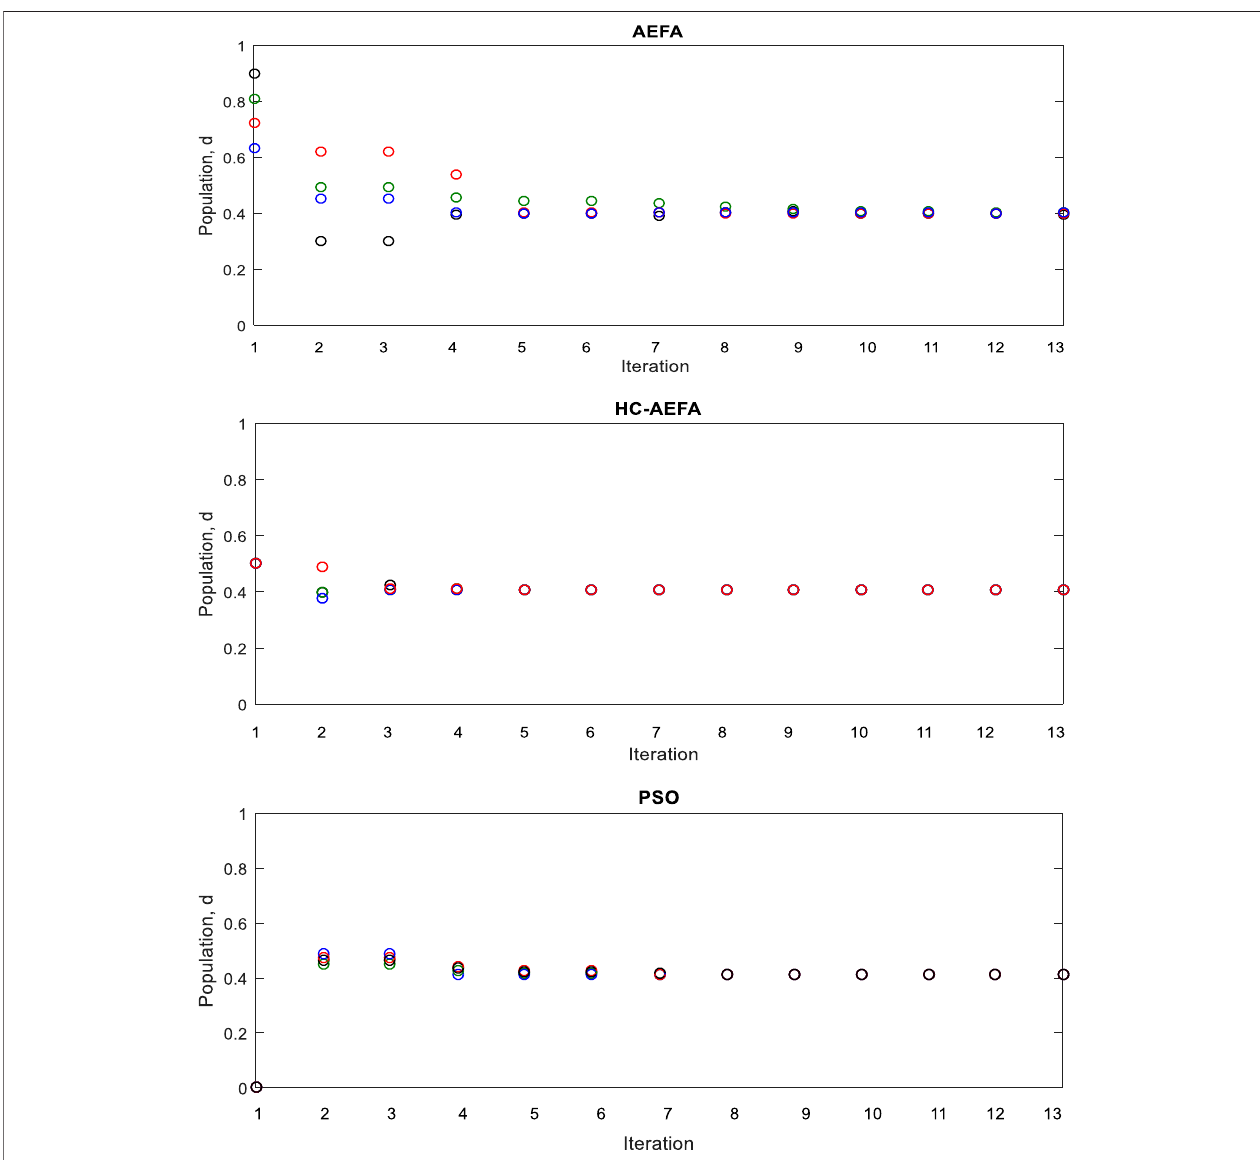
FIGURE 9 | Particles ’ positions in each iteration for the HC-AEFA, HC, AEFA, and PSO methods in the case of the second pattern.